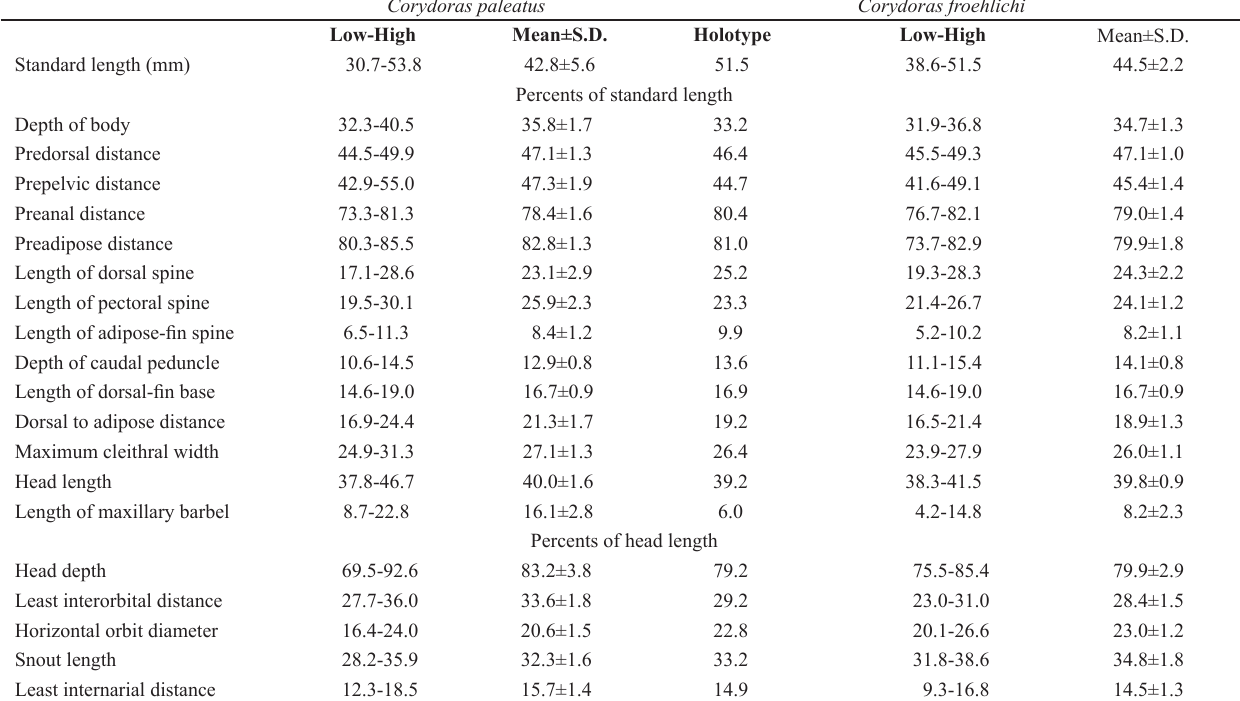
Table 1. Morphometric data of Corydoras paleatus (n = 45) and holotype and paratypes of Corydoras froehlichi (n = 32). S.D.= standard